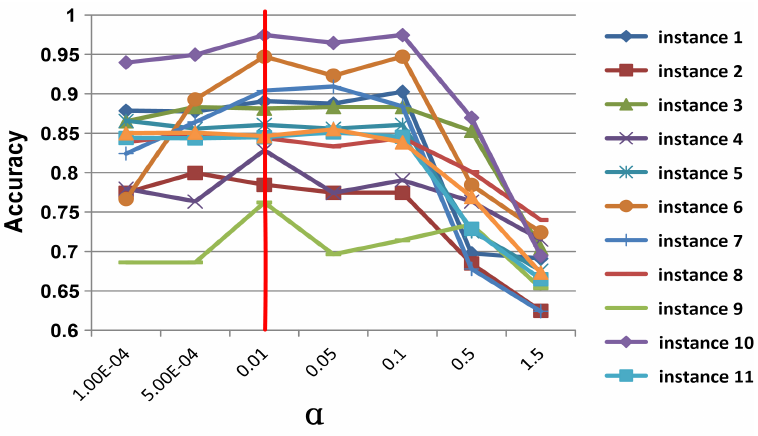
Figure 5. Parameter Influence on α of SCSA on ImageNet dataset. The y-axis represents the classifica- tion accuracy of the target domain; the x-axis represents the value range of α